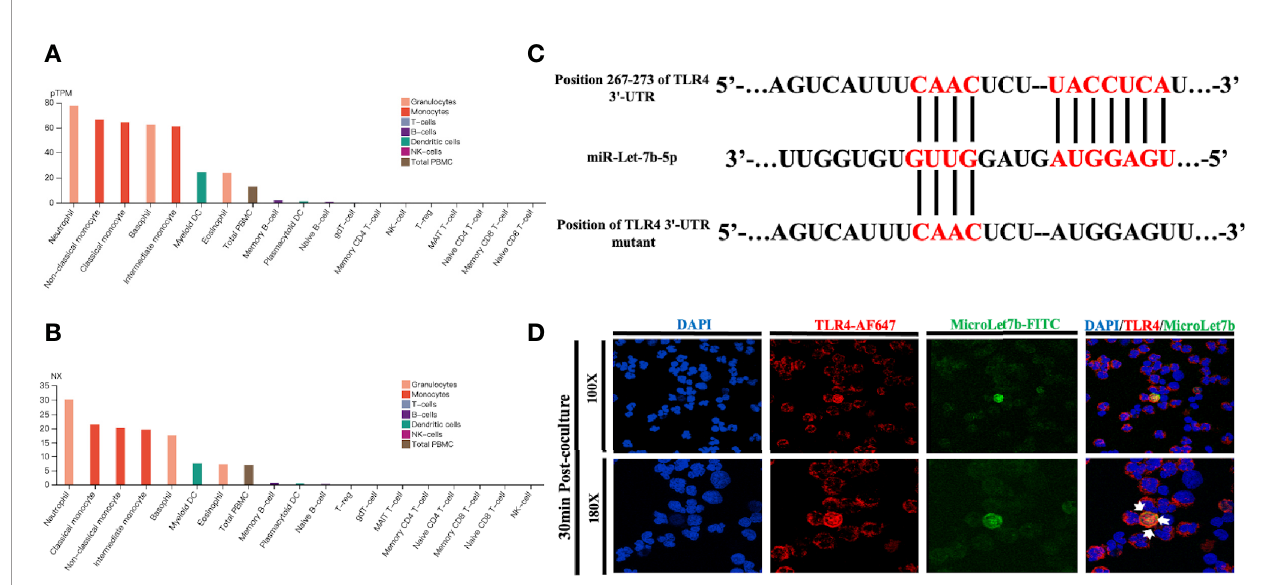
FIGURE 1 | miR-let-7b directly targets TLR4 in neutrophils. (A) Expression pro fi les based on within-sample normalized pTPM for TLR4 gene enriched in 18 blood cell types and total PBMC ranked according to protein transcript expression values (see www.proteinatlas.org for details). (B) Same as (A) , but based on the between-sample NX values. (C) The sequence of human TLR4 3 ’ -UTR (wild type and mutant) is predicted to be targeted by the mature sequence of miR-let-7b. Targeted nucleotides are labeled in red. (D) Confocal microscopy was performed on FITC-labeled miR-let-7b (green fl uorescence) and cocultured for 30 minutes with AF647-labeled neutrophil TLR4 (red fl uorescence) to demonstrate miR-let-7b internalization. Blue nuclear staining was performed with 4,6-diamidino-2-phenylindole (DAPI). One representative image of the immunostainings is shown. Scale bar denotes 100x and 180x